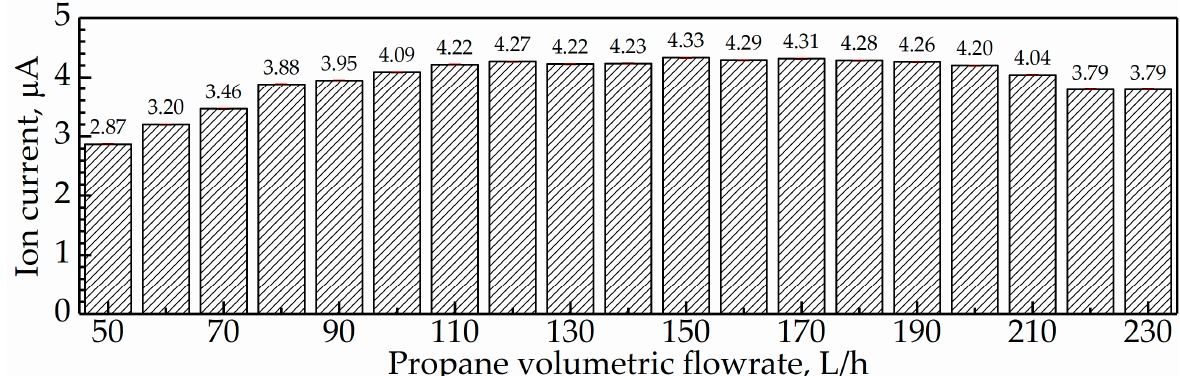
. Q f = 50–230  Q = 50–230 L/h. f